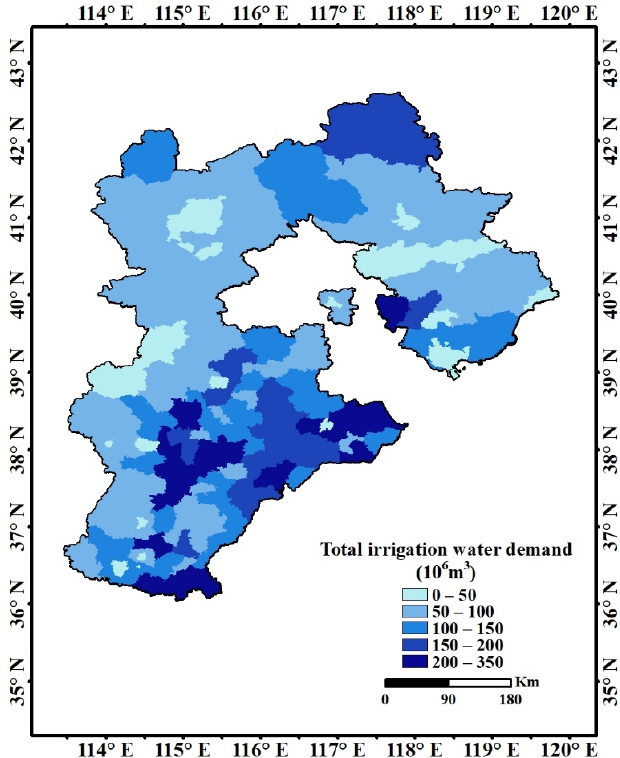
Figure 5. Spatial distribution of regional total irrigation water demand of major grain and vegetable crops from 2007 to 2017 .